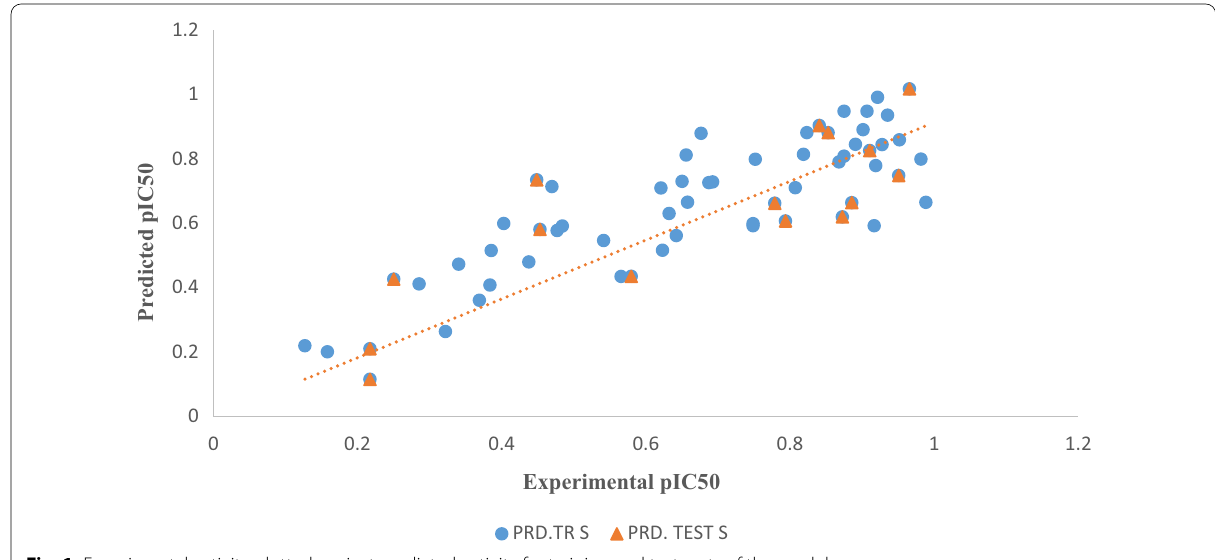
Fig. 1 Experimental activity plotted against predicted activity for training and tests sets of the